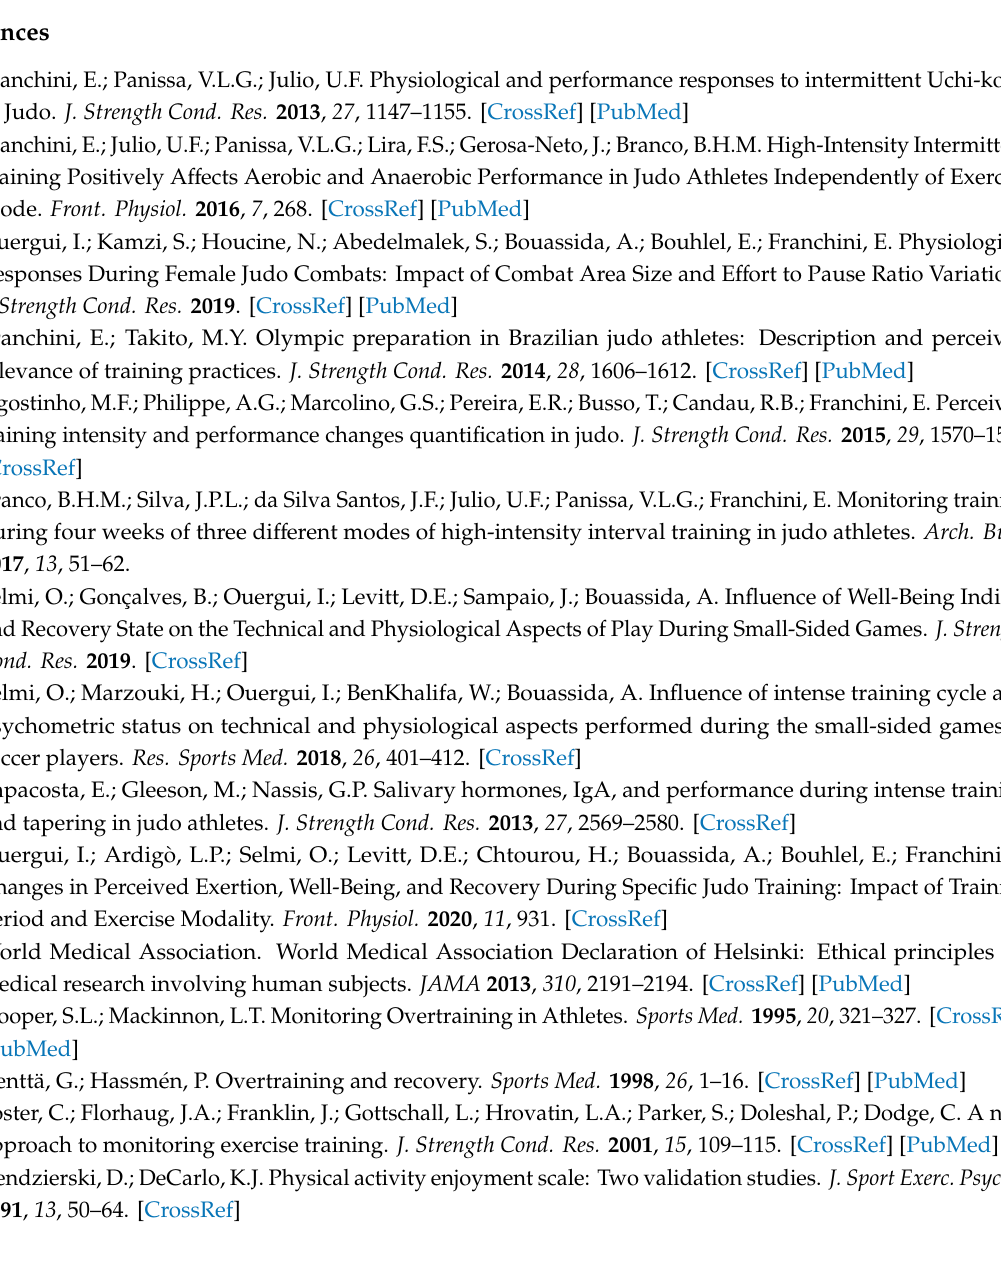
Table S2: Correlation coe ffi cients between total quality of recovery (TQR), well-being indices, rate of perceived exertion (session-RPE) and physical enjoyment (PE) during specific judo taper period (mean, n =